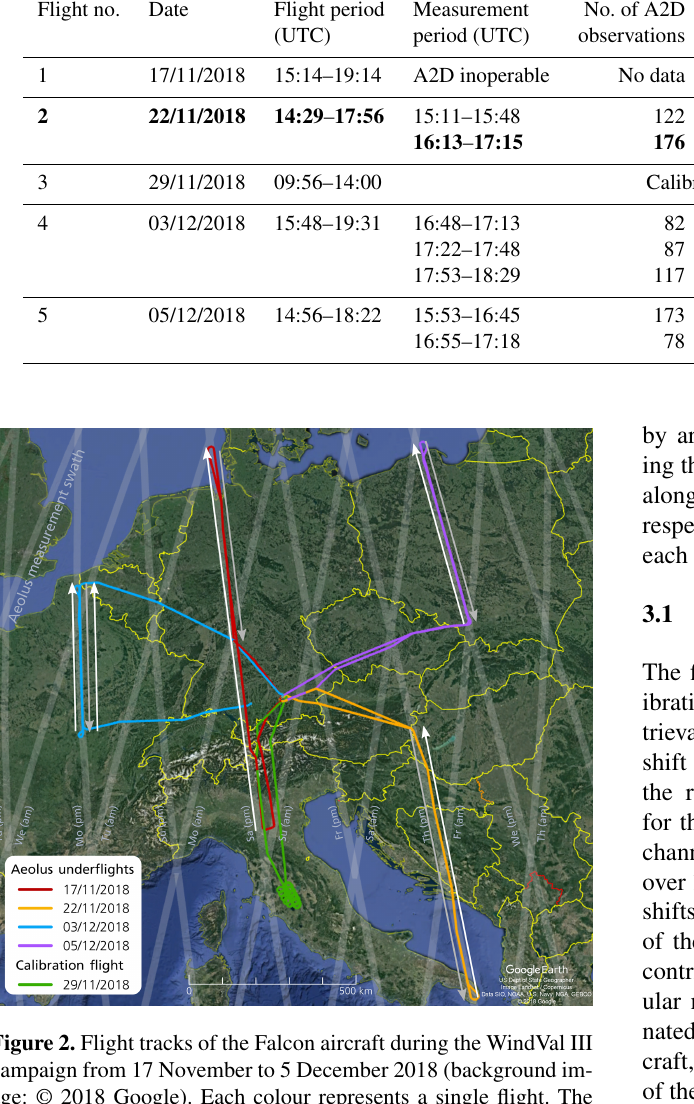
Table 2. Overview of the research flights of the Falcon aircraft in the frame of the WindVal III campaign, and the wind scenes performed with the A2D along the Aeolus measurement track. The A2D was not operable during the flight on 17 November 2018. The wind scene printed in bold is comprehensively discussed in the later sections. Flight no.